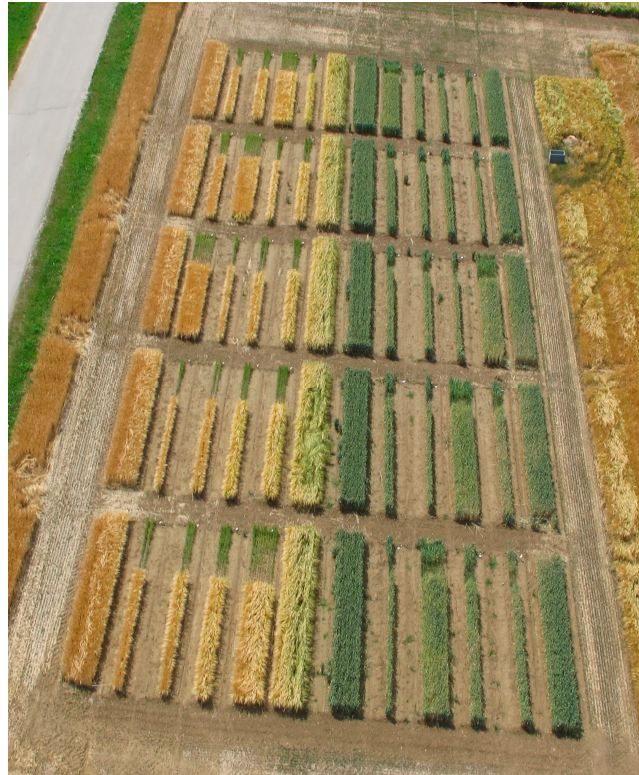
Figure 2. UAV image of the field trial. Different plot designs, including one-, two-, three- and four-row designs, were tested using winter wheat and winter barley as crops. The plots were 10 m in length. The planting-row designs consisted of plots with a single row, plots with two rows with 25-cm row spacing, and plots with three and four rows with 12.5-cm row spacing.